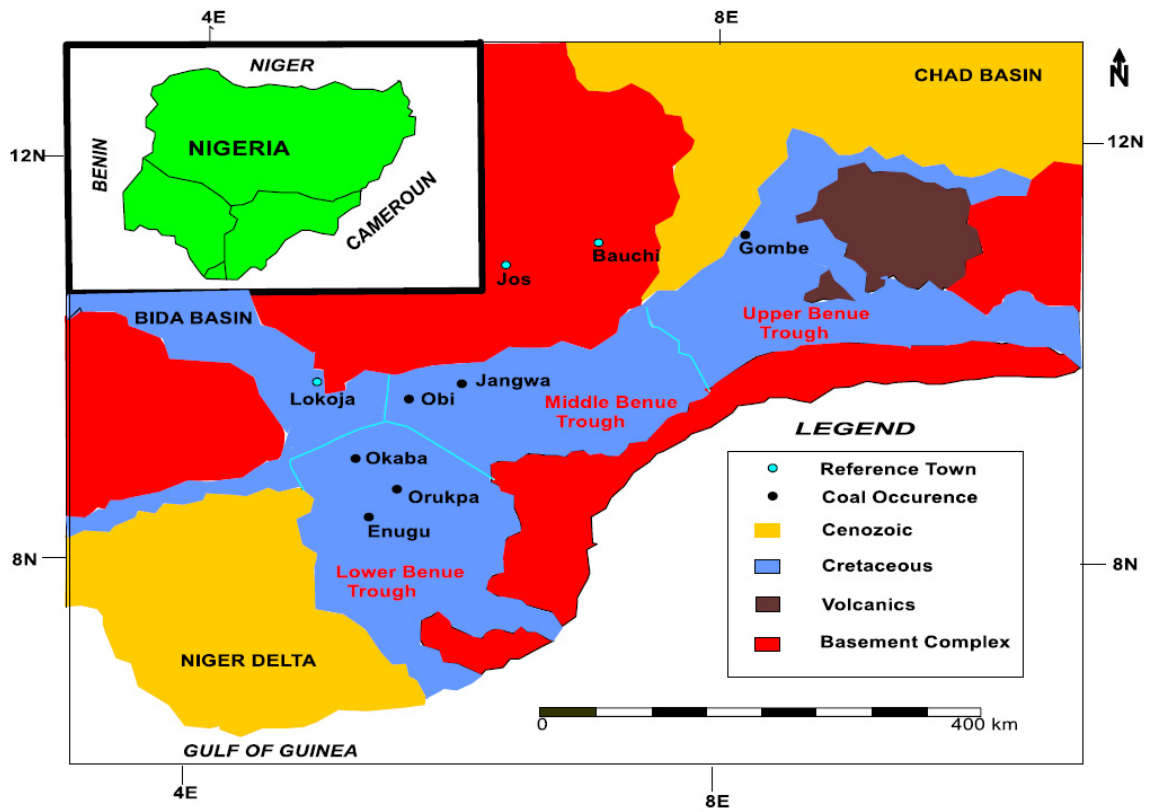
Figure 21. Geological map indicating the major coal occurrences in the Benue Trough of Nigeria (modified after Obaje et al. [150], extracted from Akinyemi et al. [146]).